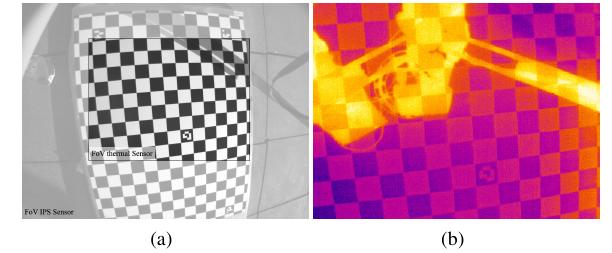
Figure 2. Comparison of feature content and field of view (FoV) between VIS and LWIR spectral range: (a) visual image with highlighted area, showing corresponding LWIR FoV (b) colour-coded LWIR image (tripod with camera setup is mirrored on the chessboard surface)